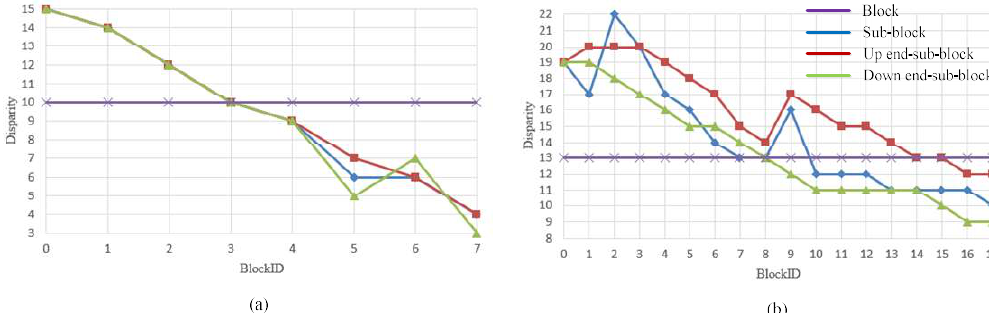
Figure 13. The ROI matching results. ( a ) Image pair block 1. ( b ) Image pair block 2.